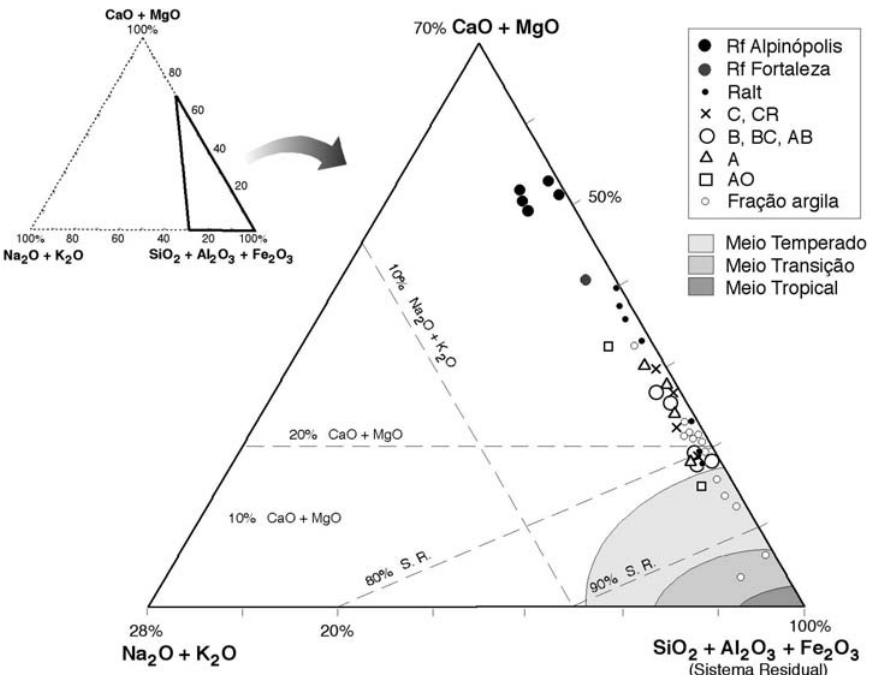
Figura 2. Avaliação da evolução geoquímica durante a alteração e pedogênese das rochas serpentinizadas, utilizando os resultados das análises químicas totais (em mol kg -1 ) e situando-os no diagrama de Chesworth (1973). Rf: rochas frescas da região de Alpinópolis (MG) (Carvalho et al., 1993) e rocha fresca amostrada nos afloramentos associados ao perfil 1 em Fortaleza de Minas (MG); Ralt.: rochas em via de